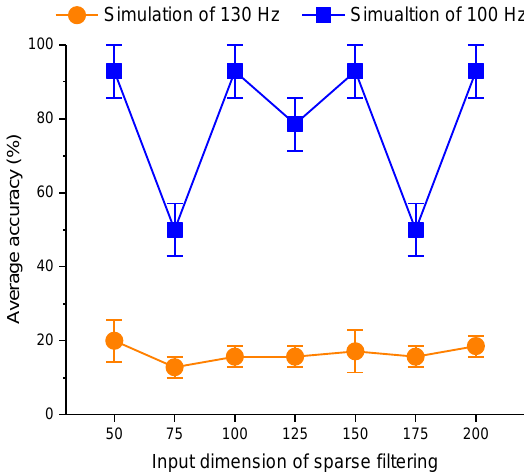
Figure 2. Diagnosis results of different input dimensions of the two harmonic signals groups.